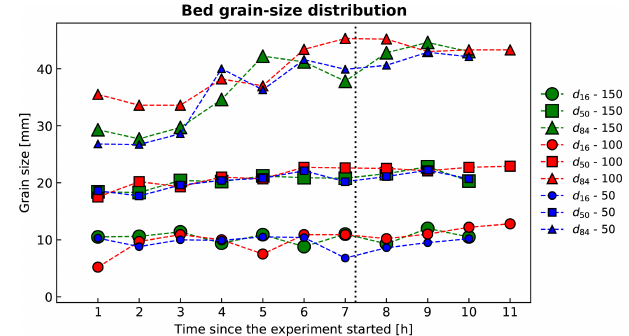
Figure 10. Grain-size distribution of the bed surface for the feed experiments. The d 16 is shown with circle, the d 50 with squares, and the d 84 with triangles. The size of the markers is proportional to the feed rate. The vertical dashed line indicates when the sediment feed was turned